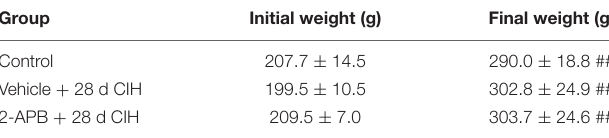
TABLE 1 | Initial and final weights of the rats during the experiments. Group Initial weight (g) Final weight